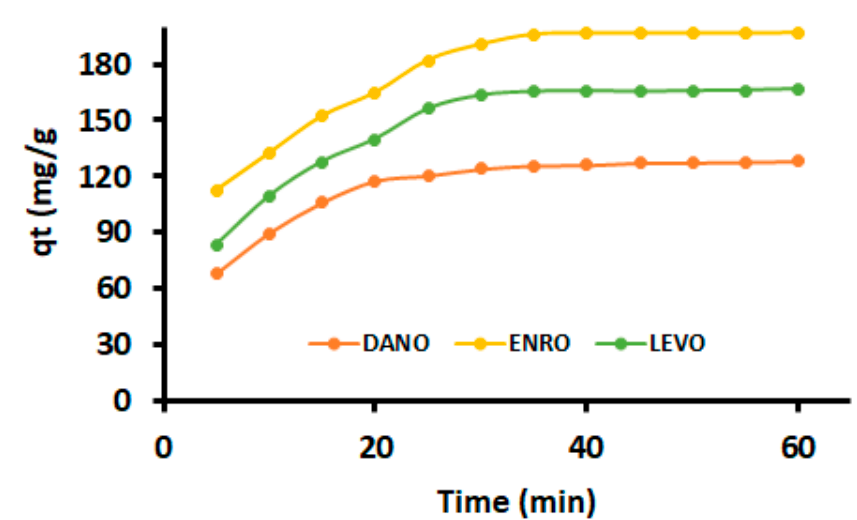
Figure 7. E ff ects of contact time on DANO, ENRO and LEVO by MMPC / Cyc-Chit kinetic modelling. Figure 7. Effects of contact time on DANO, ENRO and LEVO by MMPC/Cyc-Chit kinetic modelling.